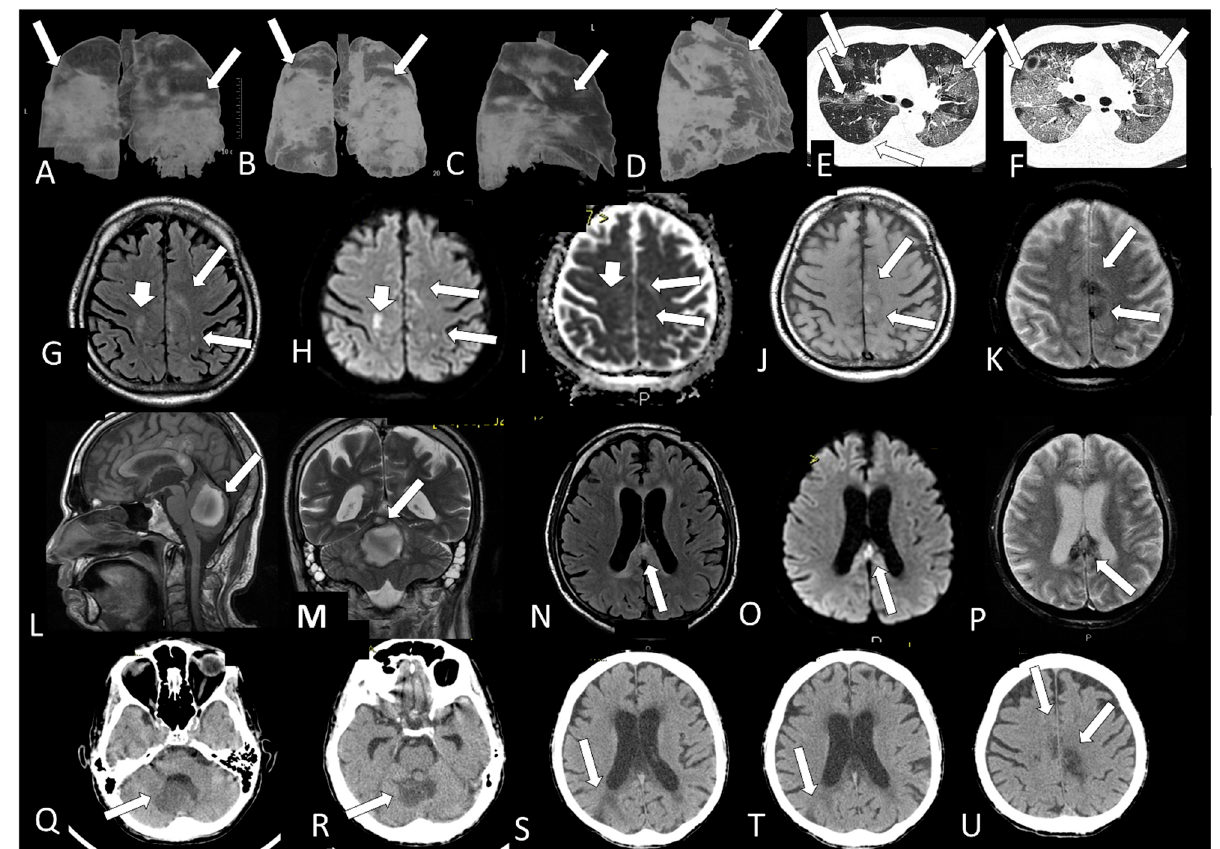
Figure 4. Case 31—The Chest CT on admission shows areas of alveoellar consolidation and ground glass in more than 50% of lung area (arrows A , C , E ). Three days later, there was a severe increase of the lung disease (arrows, B , D , F ). The brain MRI shows some hyperintense small areas on FLAIR (arrows, G ) and in DWI (arrows, H ) which are hypointense on ADC-Map (restricted diffusion lesions, arrows, I ) in both cerebral hemispheres. Small areas of microbleeding are observed, being hyperintense on T1WI ( J , arrows) and hypointense on T2* ( K , arrows) localized on the medial part of left pre and postcentral gyrus. There is also a large oval hematoma located at the vermis of the cerebellum, being hyperintense on sagittal T1 ( L , arrow) and on coronal T2WI ( M , arrow) with peripheric hypointense ring of hemosiderin. Some small lesions, which represent microbleeding (methemoglobin), are also located on the splenium of the corpus callosum hyperintense on FLAIR ( N , arrow) and on DWI ( O , arrow) being hypointense on T2* ( P , arrow). The CT ( Q – U ) without contrast made one month later showed that the lesions described above on previous MRI are hypointense and that a new sequel in the right parietal lobe ( S , T , arrow) had appeared.